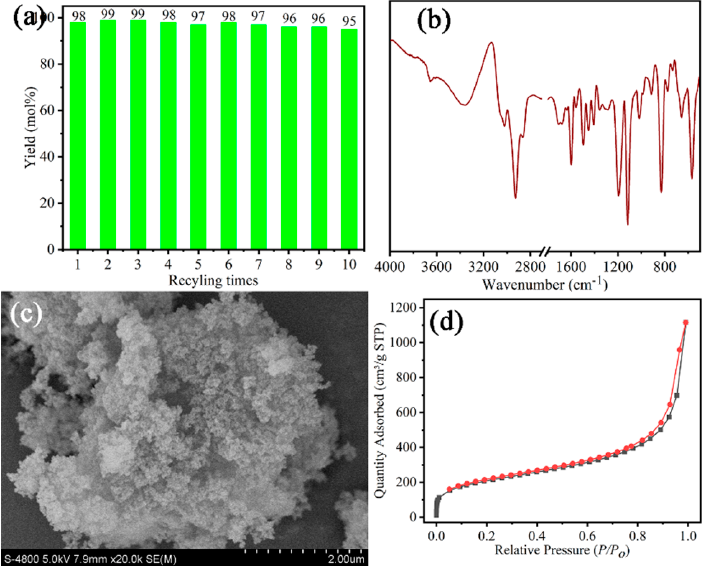
Figure 7. ( a ) Catalytic reusability of PQPBr-2OH. Characterizations of the recycling of the PQPBr-2OH catalyst after reusing it ten times: ( b ) FT-IR, ( c ) SEM, and ( d ) Nitrogen sorption isotherms.